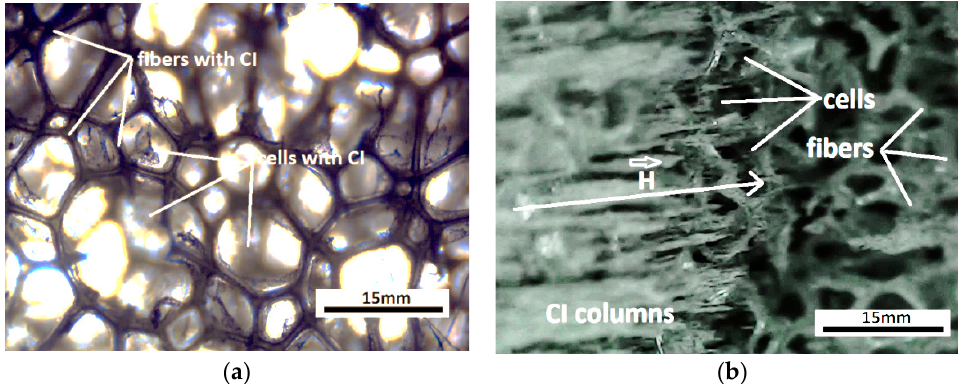
Figure 6. The MPS viewed under a digital microscope: ( a ) In the absence of the magnetic field; ( b ) in the presence of the magnetic field ( H ≈ 40kA m⁄ ).